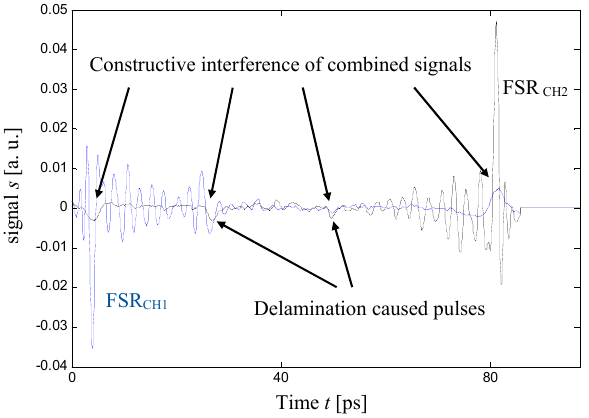
Figure 10. Exemplary results of double-sided pulsed THz measurements for given ( x , y ) position (signal from channel 2 was multiplied by − 1 and time-reversed according to the proposed algorithm). Appl. Sci. 2017 , 7 , 661